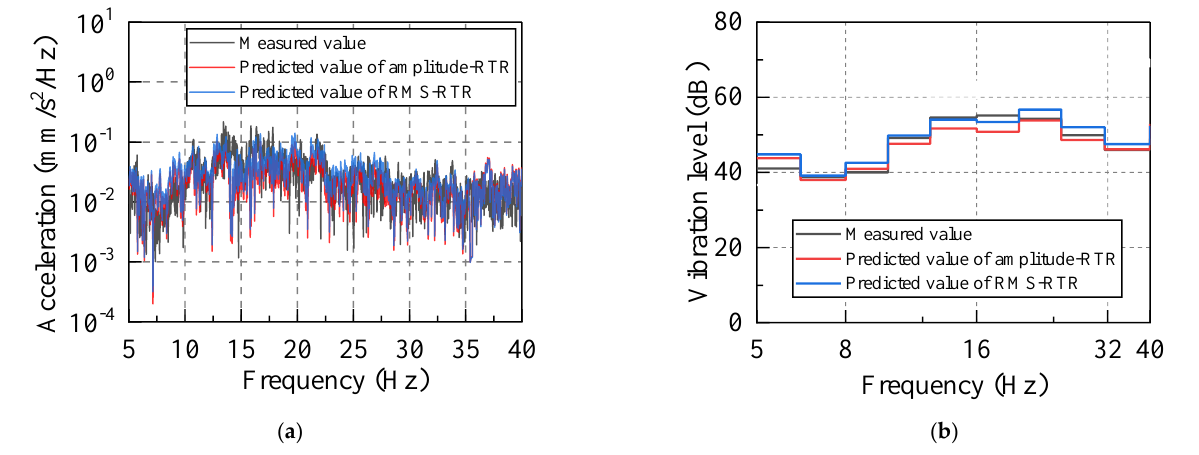
Figure 18. The frequency − domain calculation results of the measured and predicted values: ( a ) Power spectra density, ( b ) 1/3 − octave.